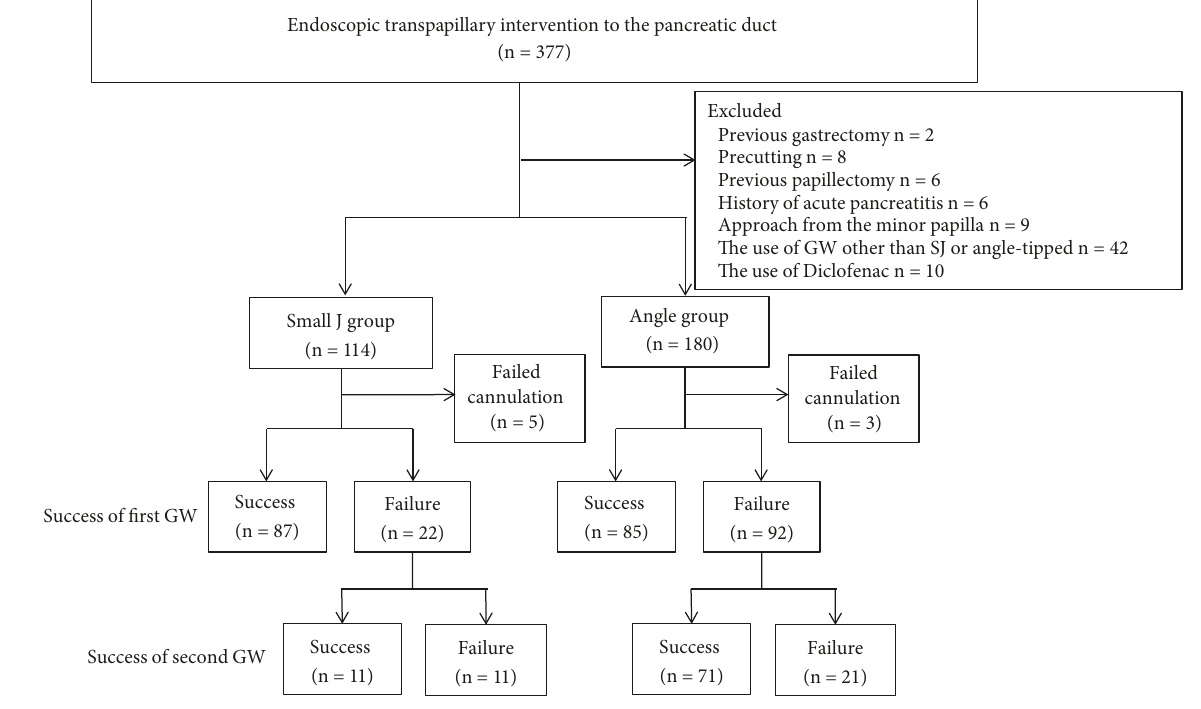
Figure 2: Participant flow, including clinical courses in this